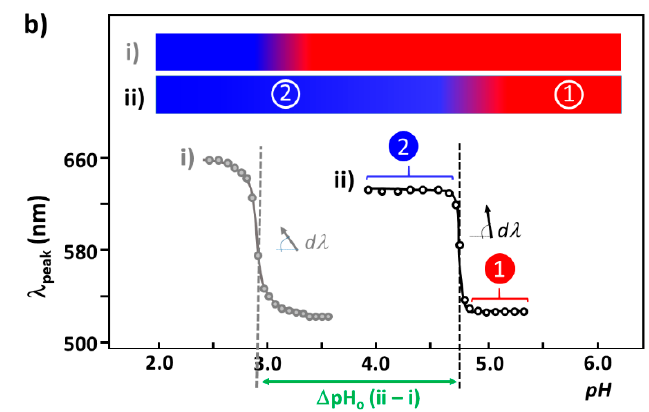
Figure 12. A schematic diagram explaining the spectral analysis and construction of sigmoidal plots. ( a ) The average peak position of SPR, λ peak , was monitored as a function of the pH condition for both bare gold nano-particles and peptide-coated nano gold colloids. The λ peak was extracted by utilizing the method described in Section 4.3.1. Two representative spectrum marked by ① and ② represent that under pH 7 and pH 2, respectively. ( b ) The constructed sigmoidal plot was fit with the Boltzmann formula shown in Equation (1). Both d pH and ∆ pH o were obtained. Here, the sigmoidal plot i indicates that of bare gold colloid, and the sigmoidal plot ii is a typical plot observed for amyloidogenic peptide coated gold nano-particles. The upper colored bar shows the corresponding solution color for regions ① and ② .